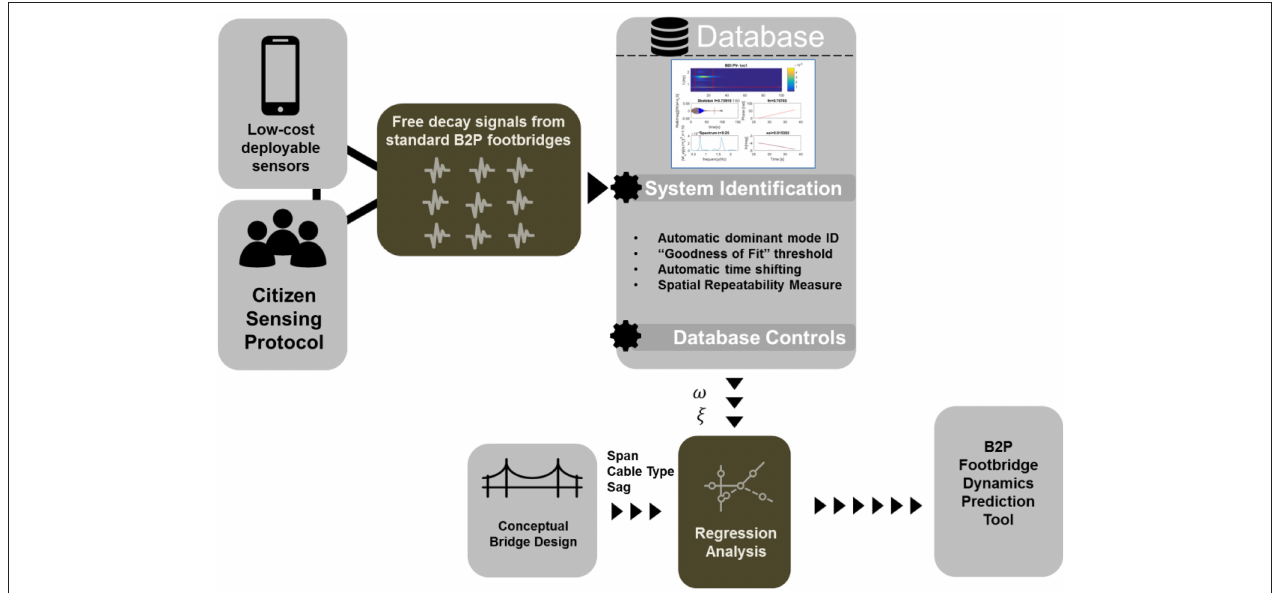
FIGURE 7 | Sorting into modal groupings and subsequent SI for multiple modes at a single sensor location.